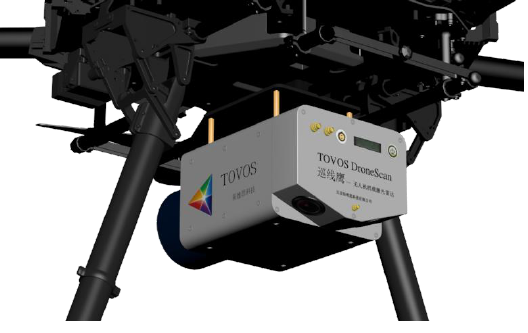
Figure 2. Tovos DroneScan mounted on DJI M600 pro